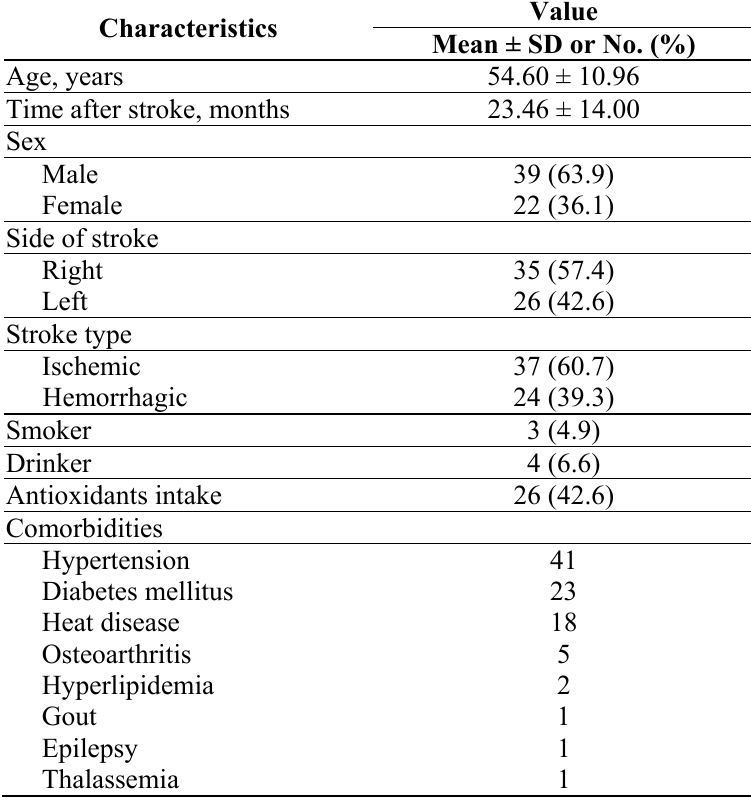
Table 1. Demographic and clinical characteristics of the patients with stroke ( N =